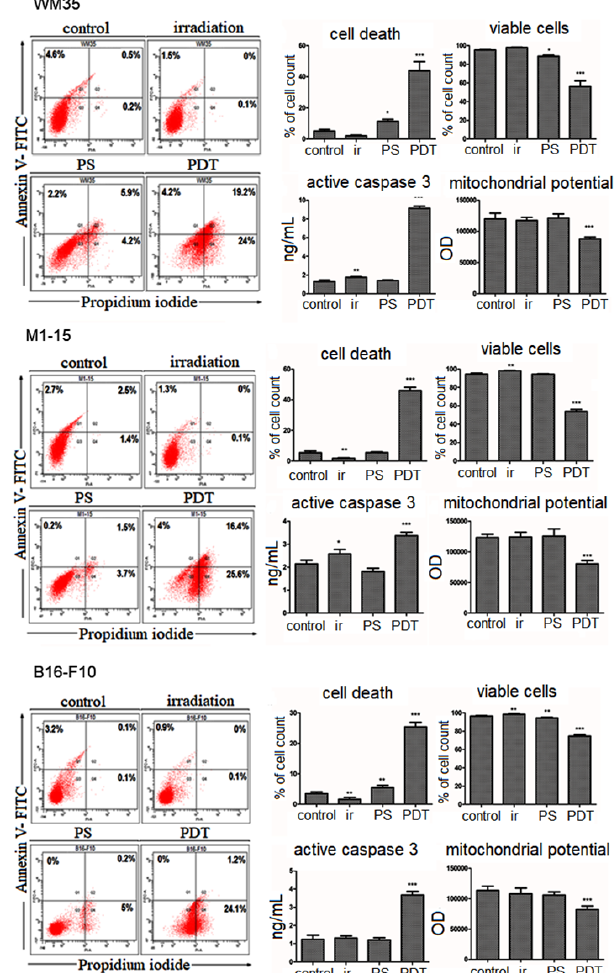
Figure 3. Cell death induction. Comparative FACS analysis (left), quantitative FACS results (% of total cells counted)—viable cells annexin V ( − )/PI ( − )—Q3, early apoptotic cells annexin V(+)— Q1, necrotic cells PI (+)—Q4, late apoptosis annexin V (+)/PI (+)—Q2 quadrant, a minimum of 10,000 events were quantified for each lot. Active caspase 3 (ng/mL); mitochondrial potential (OD570 nm) (right) for WM35 (upper panel), M1-15 (middle panel), and B16-F10 (lower panel), * = p < 5.0 × 10 − 2 , ** = p < 1.0 × 10 − 2 , ***= p < 1.0 × 10 − 3 , compared to controls. 1 = control, 2 = irradiated (100 mJ/cm 2 ), 3 = THPP (15 µ g/mL), 4 = PDT (THPP 15 µ g/mL and irradiation 100 mJ/cm 2 ) (left). Each bar represents mean ± standard deviation ( n = 3).